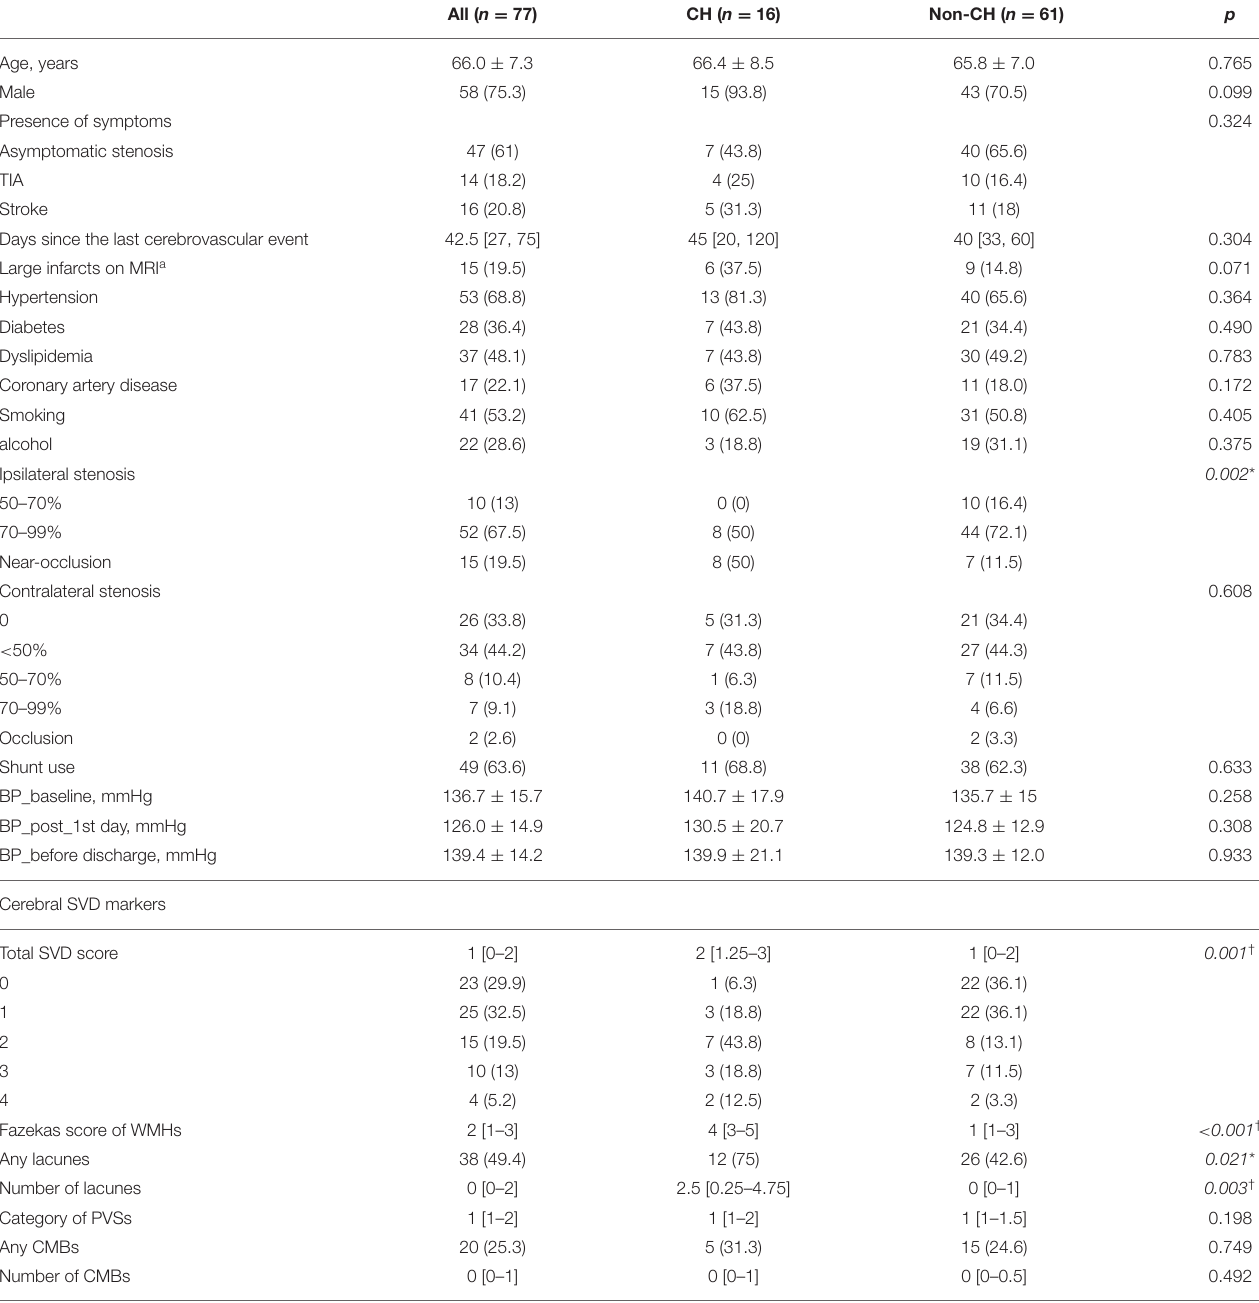
TABLE 2 | Clinical characteristics and cerebral small vessel disease markers of